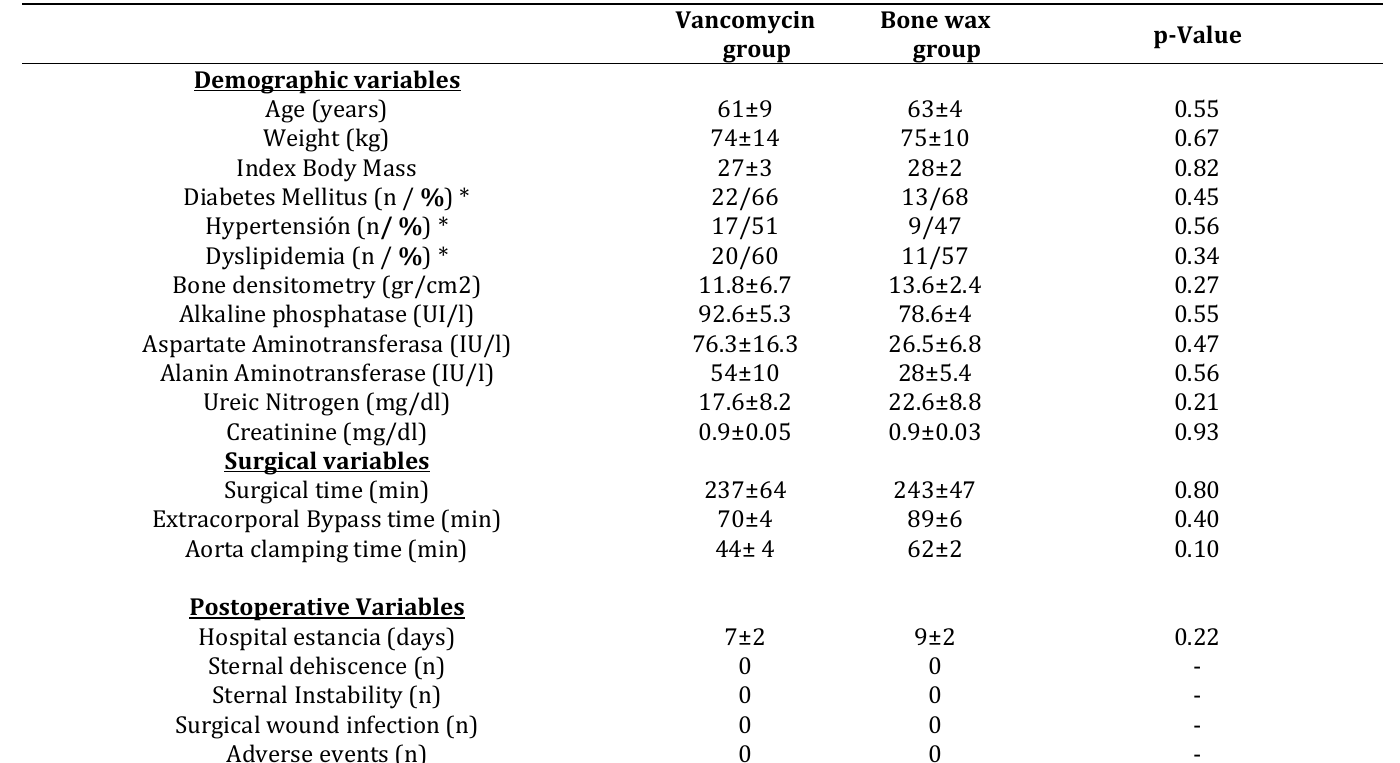
Table 1. Demographic, surgical and postoperative